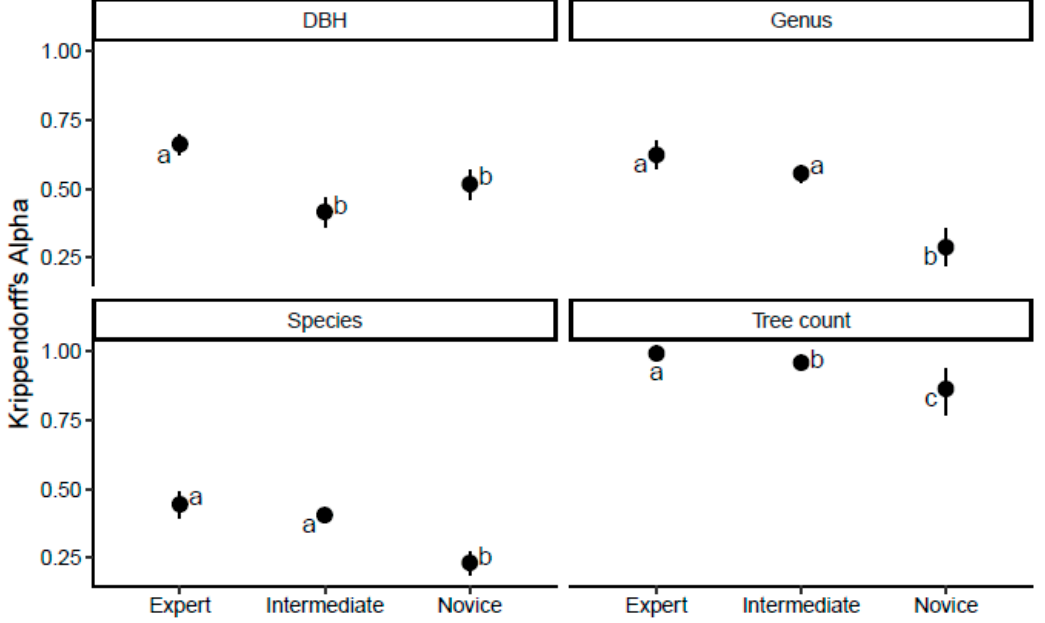
Figure 2. Krippendorff’s alpha scores summarizing interrater agreement within analyst expertise groups by tree variable, with 95% confidence intervals. For each variable, different letters indicate significantly different analyst agreement across expertise groups.